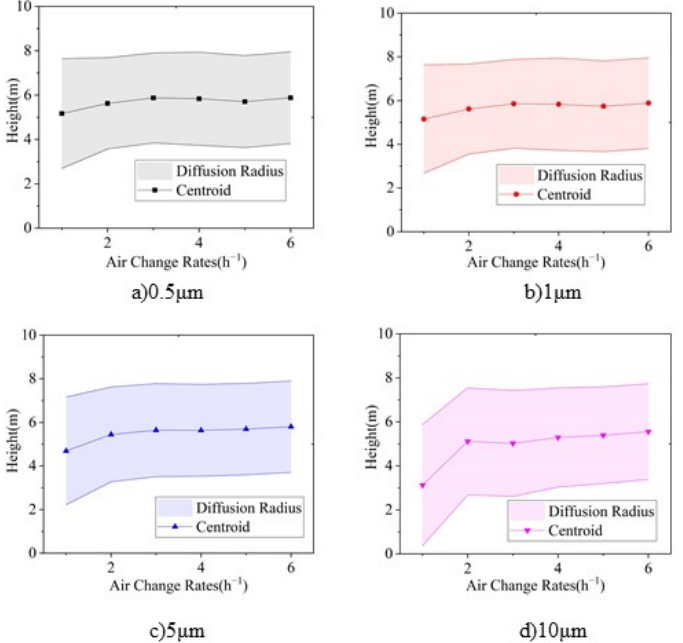
Figure 15. Relationship between centroid height, diffusion radius, and stratification height at each particle size with respect to the air change rate: ( a ) 0.5 μ m, ( b ) 1 μ m, ( c ) 5 μ m, and ( d ) 10 μ m.